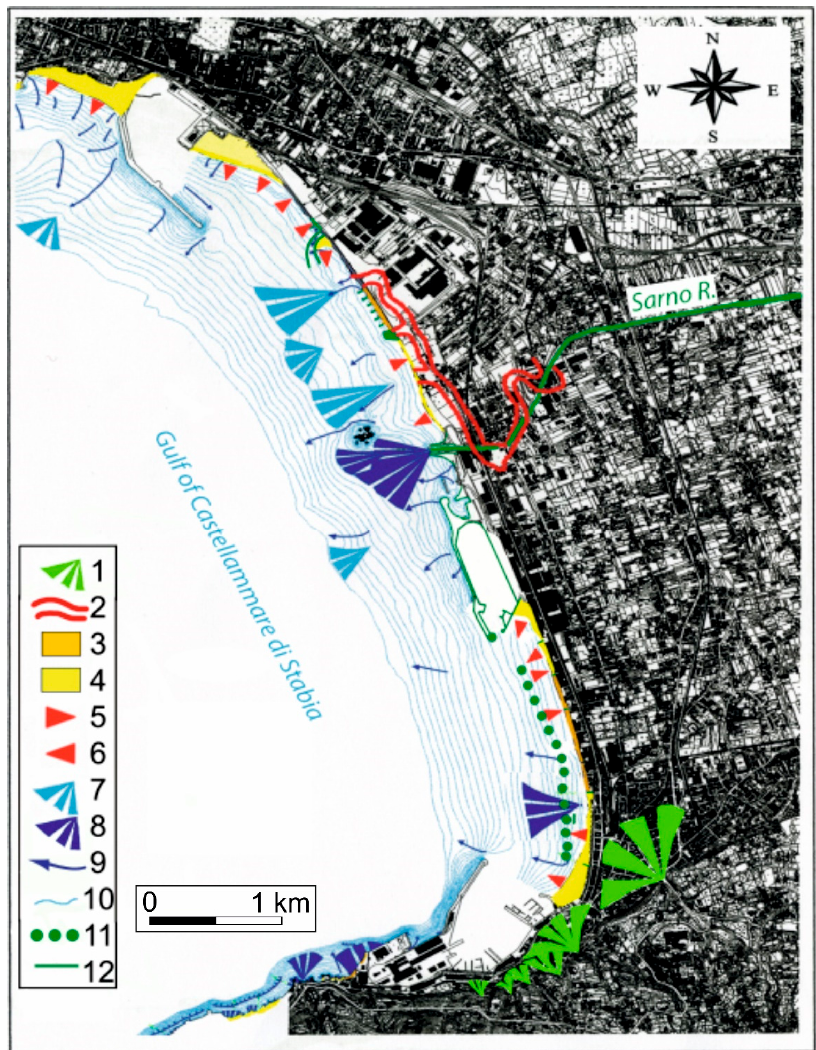
Figure 3. Schematic geomorphological map of Castellammare di Stabia coastal area. Legend: (1) alluvial fan deposits in piedmont areas (Holocene); (2) Sarno paleo-riverbed; (3) sandy, gravelly beaches; (4) sandy beaches; (5) erosional beach; (6) progradational beach; (7) Sarno river’s ancient mouth complex; (8) Sarno river’s current mouth complex; (9) channel incised in the bottom; (10) isobaths (1 m interval); (11) detached submerged breakwaters; (12) Recent coastal engineering works.